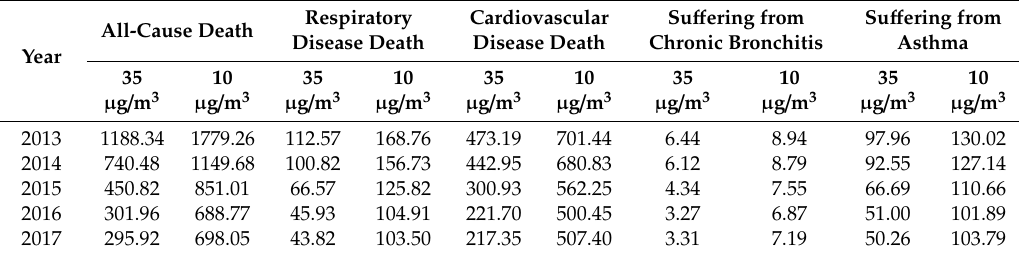
Table 6. ValueassessmentofhealthlosseswhenPM 2.5 dropsto35 µ g / m 3 and10 µ g / m 3 (unit: milliondollars). Respiratory All-Cause Death Disease Year